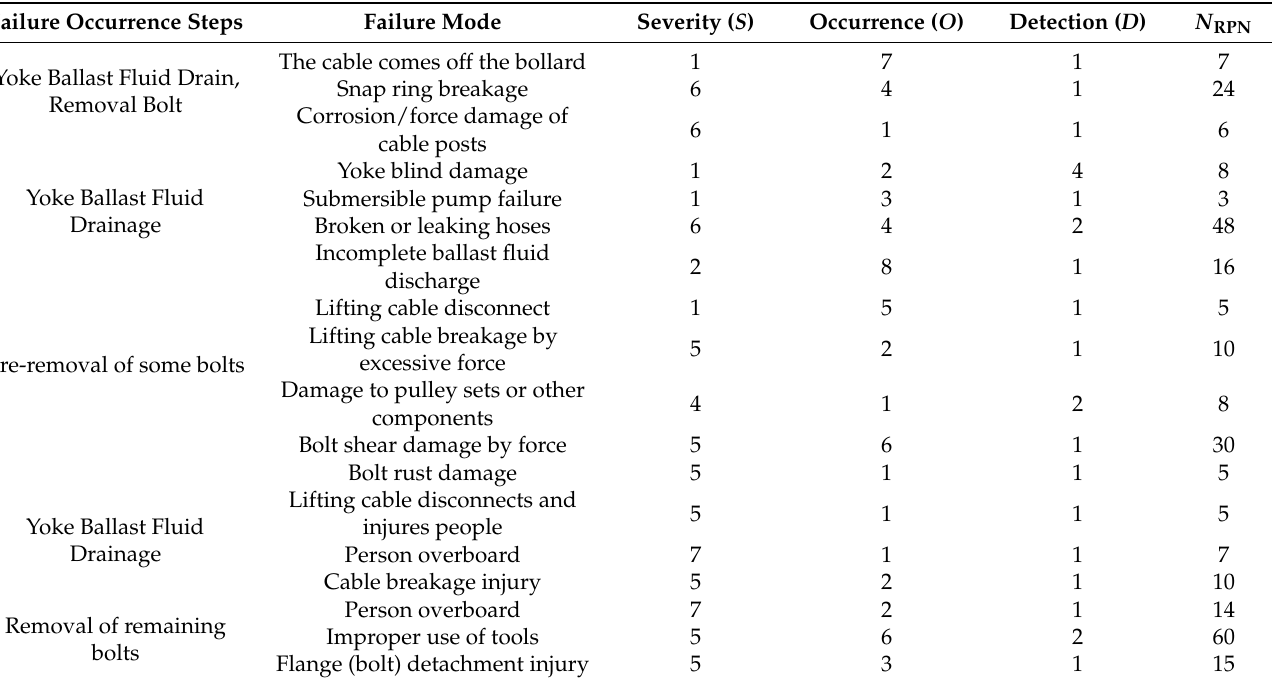
Table 3. Yoke offloading